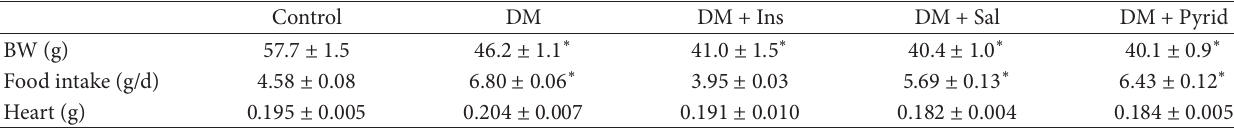
∗ P < 0.05 versus Control; data are expressed as mean ±